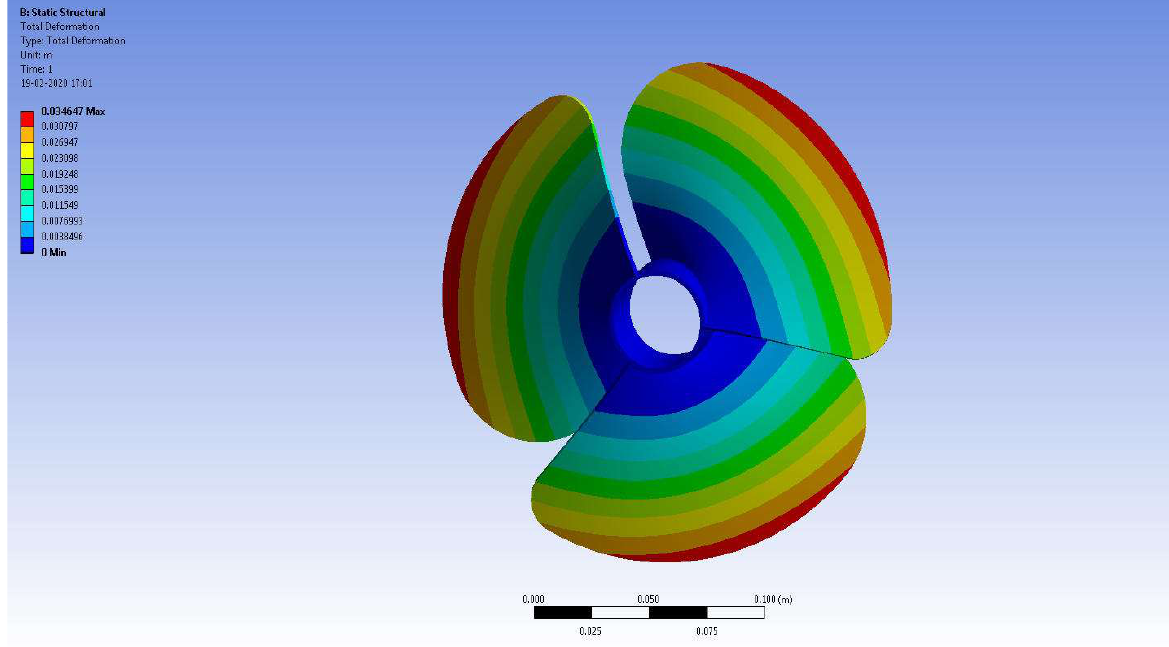
Figure 22. Distribution of deformation at 300 m depth with 20 m/s fluid velocity—CFRP-Prepreg-